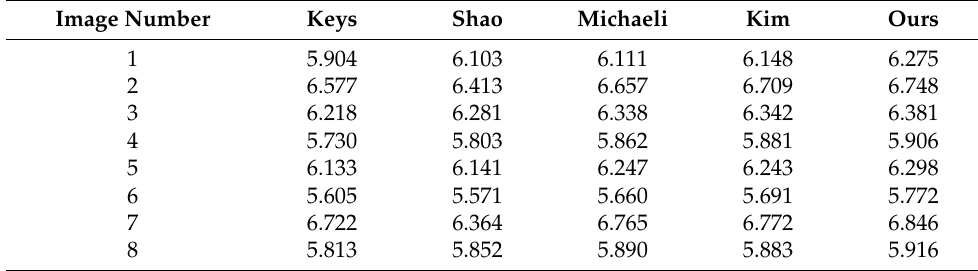
Table 2. Comparison of IE indexes of images reconstructed using different methods.